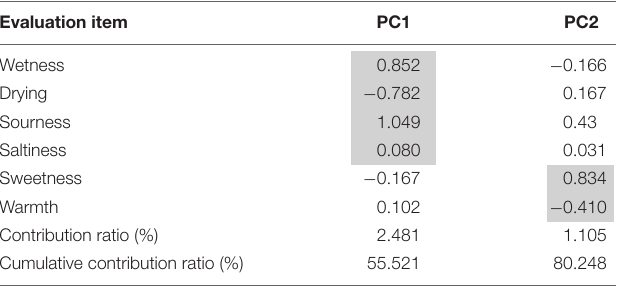
TABLE 4 | Result of principal component analysis: principal component loadings of six adjective